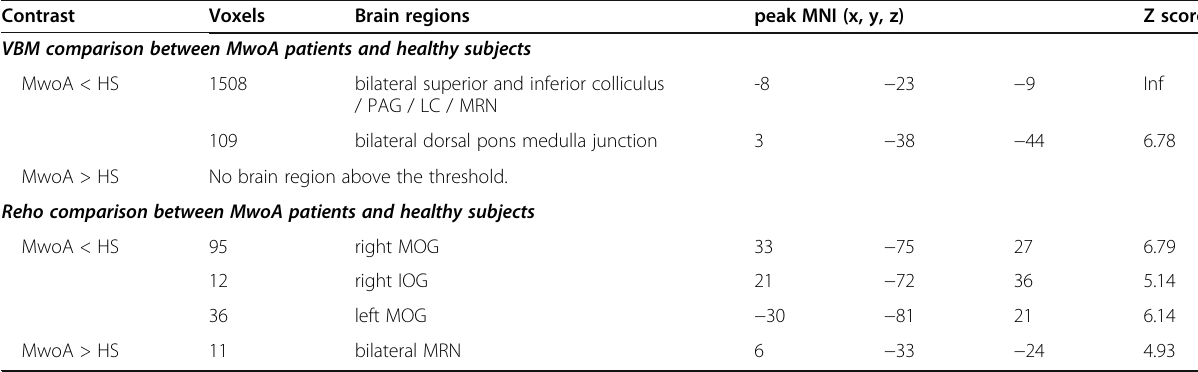
Table 2 The VBM and Reho comparisons between MwoA patients and healthy subjects Contrast Voxels Brain regions peak MNI (x, y, z) Z score VBM comparison between MwoA patients and healthy subjects MwoA < HS 1508 bilateral superior and inferior colliculus -8 − 23 − 9 / PAG / LC / MRN 109 bilateral dorsal pons medulla junction MwoA > HS No brain region above the threshold.